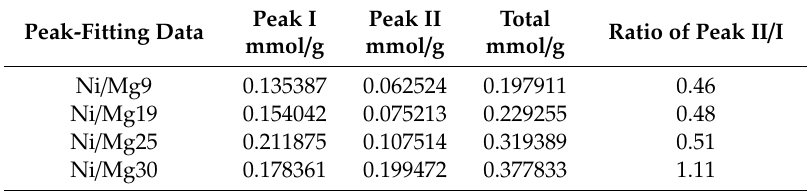
Figure 8. CO 2 -TPD profiles of Ni/Mg-aluminate catalysts. Table 2. The amount of CO 2 desorption calculated based on CO 2 -TPD prfiles of Ni/Mg-aluminate catalysts.